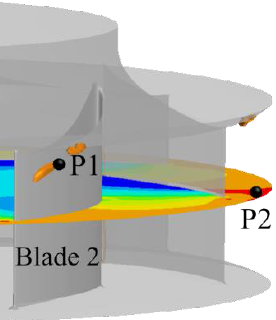
Figure 12. Monitor points P1 and P2. The instantaneous pressure in Plane 2 and the iso-surface of 𝑝 = 340 𝑃𝑎 colored orange.